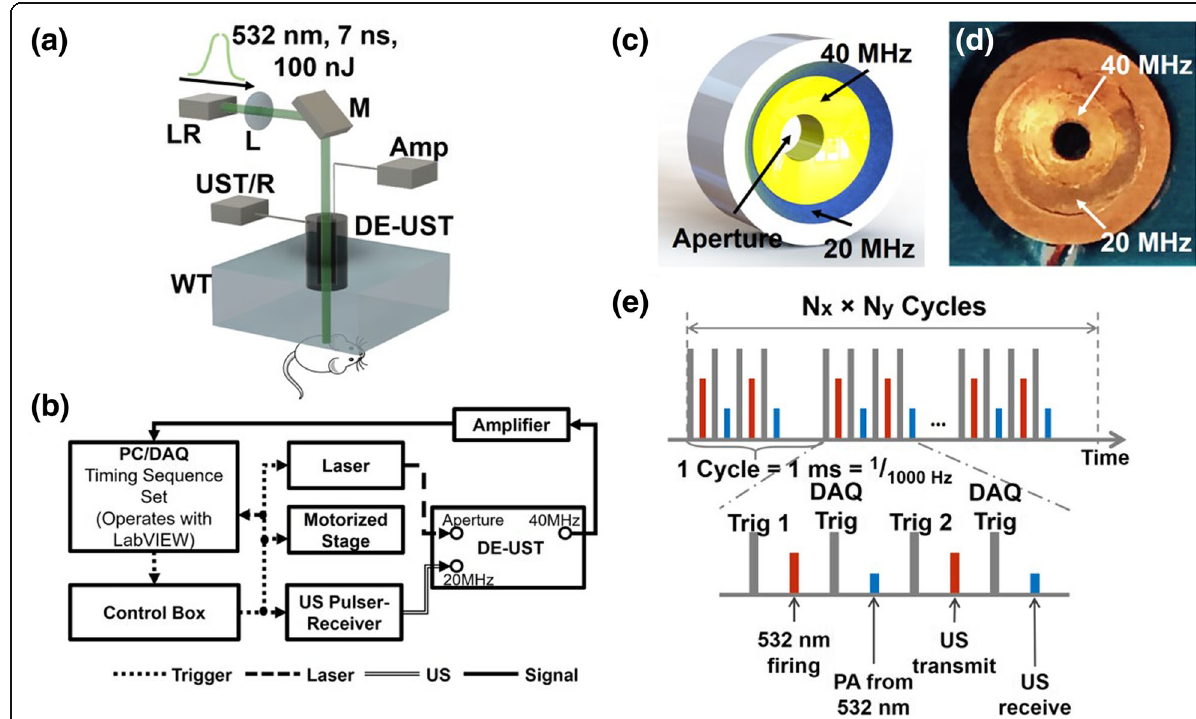
Fig. 1 Concurrent PAUS microscopy. a The schematic of the PAUS microscopy system. LR, laser; L, lens; M, mirror; UST/R, ultrasonic pulser-receiver; Amp, amplifier; WT, water tank with transparent bottom. The mouse was placed under a small water tank on a 3D motorized translation stage (not shown) with the hind leg fixed on a sample holder. b Experimental timing sequence chart. A LabVIEW program sends out triggers to the laser, ultrasonic pulser-receiver, stage, and DAQ. c , d Structure and photo of the DE-UST with a central aperture. The high frequency element (40 MHz) is inside and the low frequency element (20 MHz) is outside. e Detailed timing sequence. Trigger 1 is for 532 nm laser firing, followed by a DAQ trigger that starts data acquisition for the PA signal. Trigger 2 is for US transmission, followed by a DAQ trigger that starts data acquisition for the US signal. The A-line acquisition frequency is 1000 Hz, and the sampling frequency for each A-line is 250